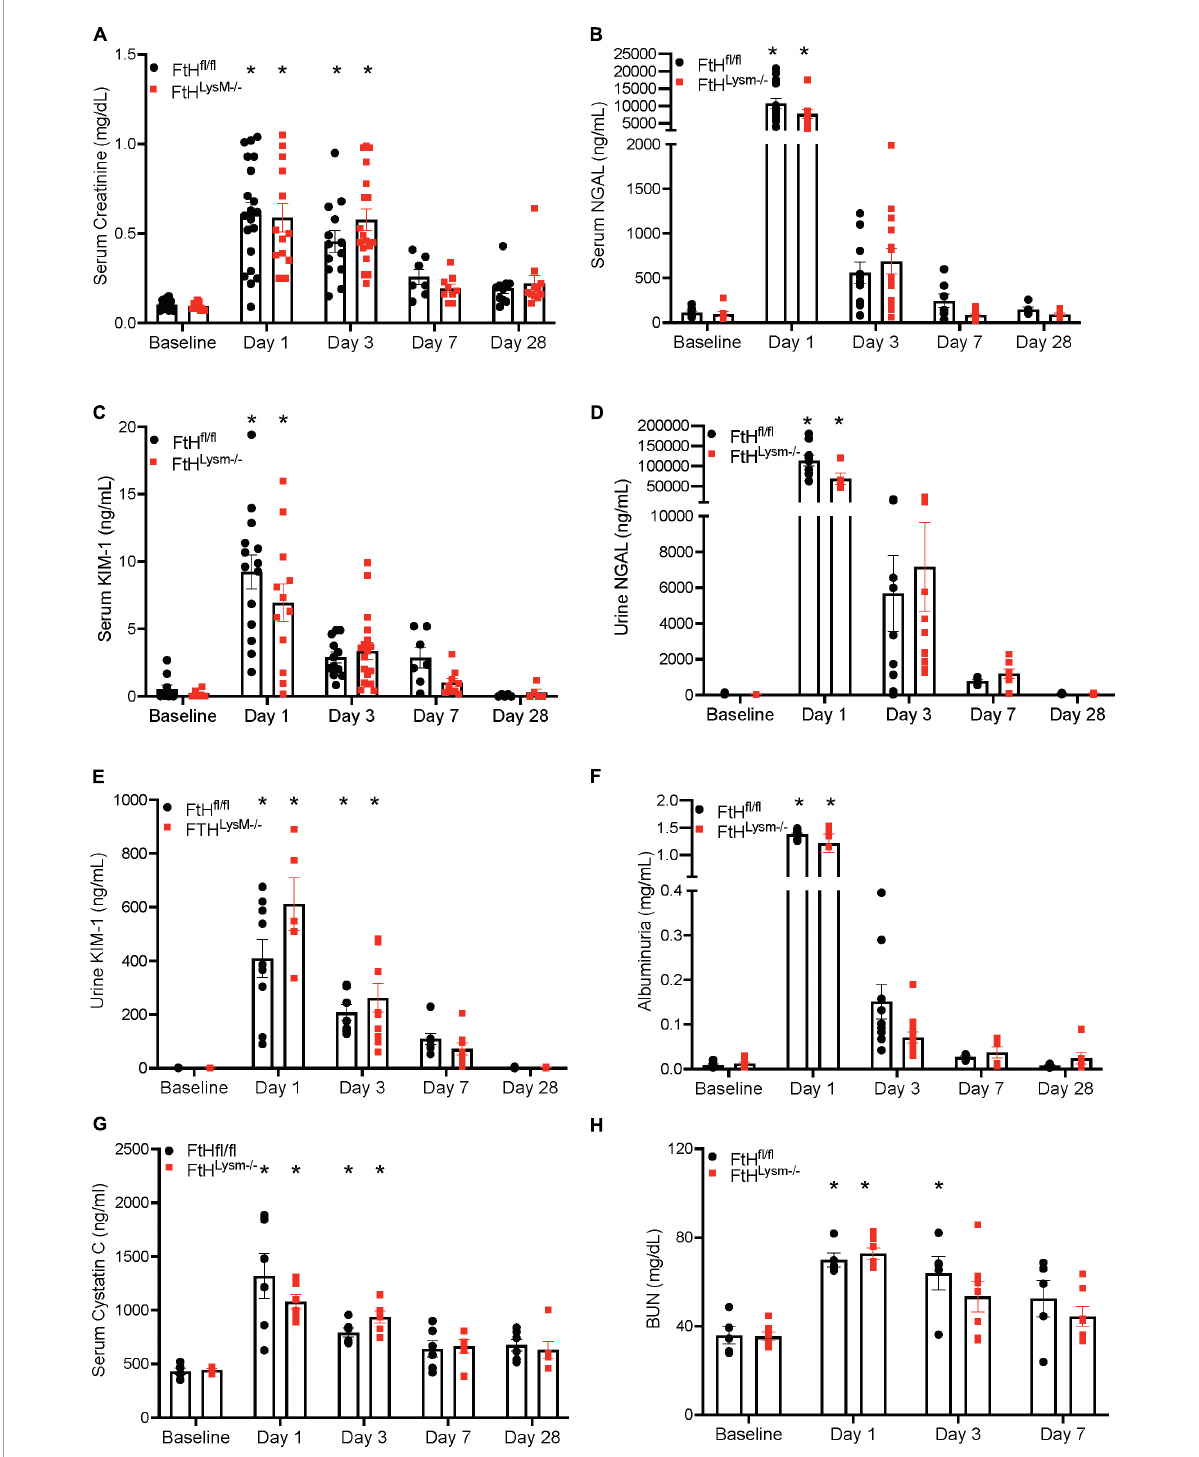
FIGURE1 Myeloid FtH deficiency does not impact rhabdomyolysis-acute kidney injury. Mice were administered 7.5 ml/kg body weight of 50% glycerol in water and harvested after 1, 3, 7, or 28 days. Serum was analyzed for (A) creatinine expressed in milligrams per deciliter (mg/dl), (B) neutrophil gelatinase associated lipocalin (NGAL) expressed in nanograms per milliliter (ng/ml), (C) kidney injury molecule-1 (KIM-1) expressed in ng/ml. Urine was analyzed for (D) neutrophil gelatinase associated lipocalin (NGAL) expressed in ng/ml, (E) kidney injury molecule-1 (KIM-1) expressed in ng/ml, (F) albumin expressed in milligrams per milliliter (mg/ml), (G) serum cystatin C expressed in ng/ml. (H) BUN expressed in mg/dl. All data are expressed as mean ± SEM. * p < 0.05 vs.